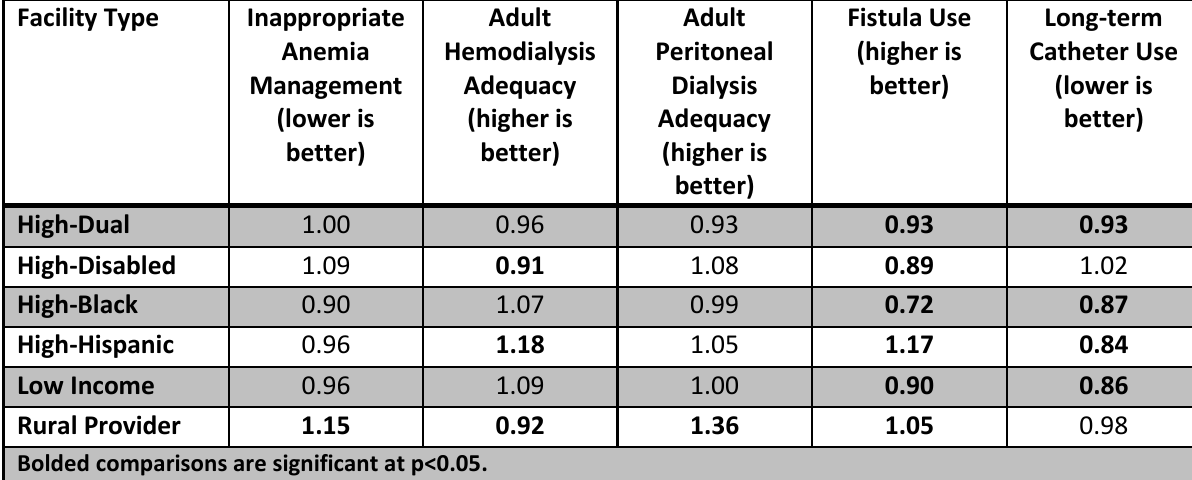
Table 11.5: PY 2015 ESRD QIP Quality Measures and Facility Level of Social Risk Factors Facility